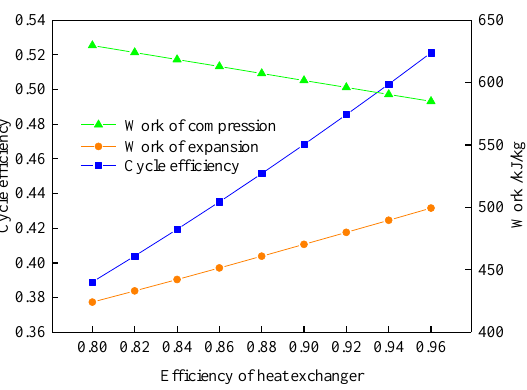
Figure 4. Influence of heat exchanger effectiveness on the compression work, expansion work, and the cycle efficiency.